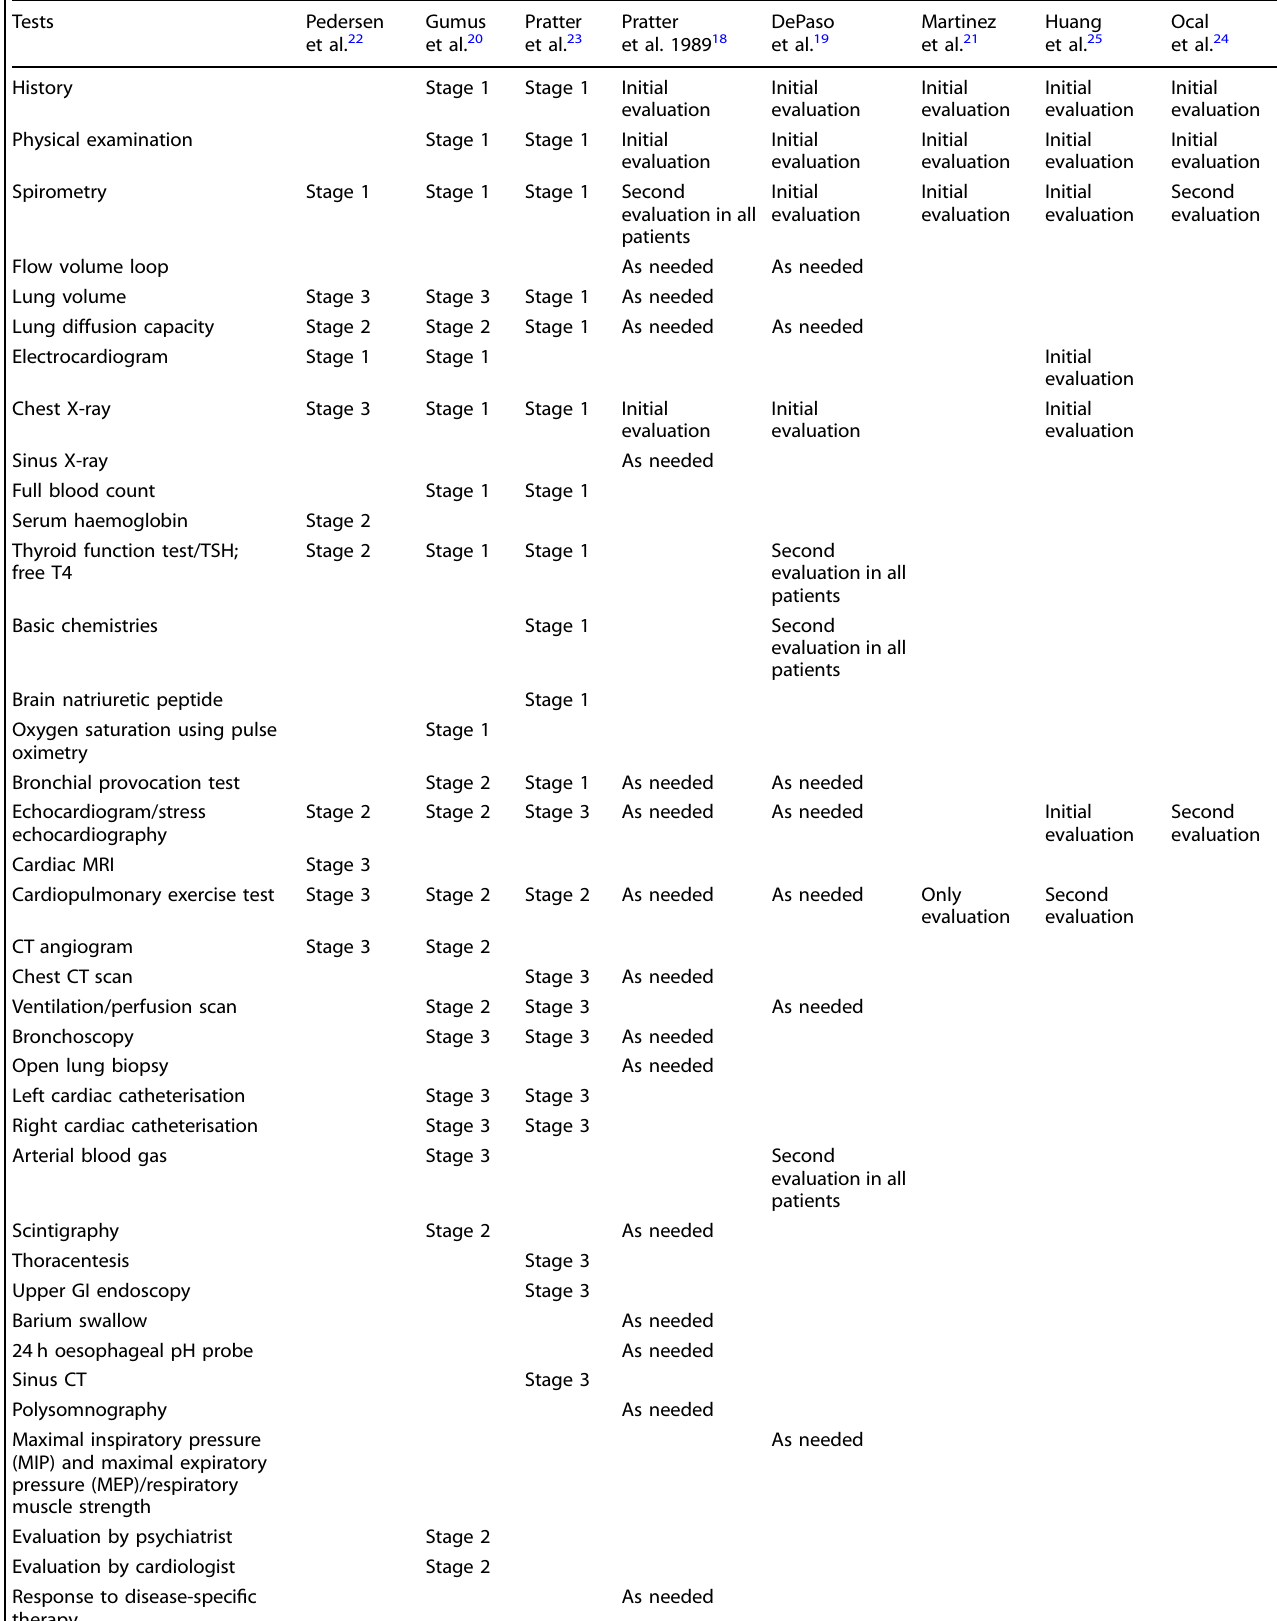
Table 2. List of investigations used in the studies and the order in which they are utilised for assessment of dyspnoea when